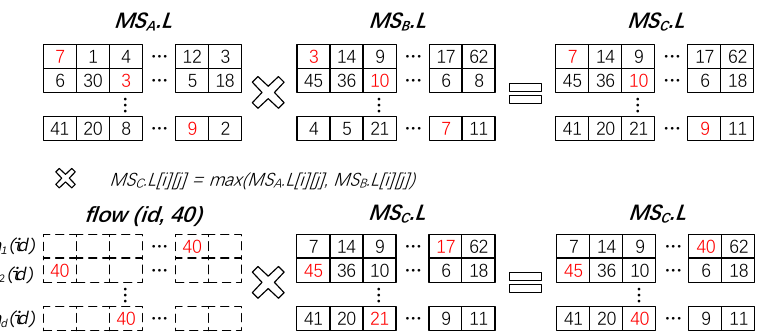
Figure 5. Critical part of the merge algorithm in the merge